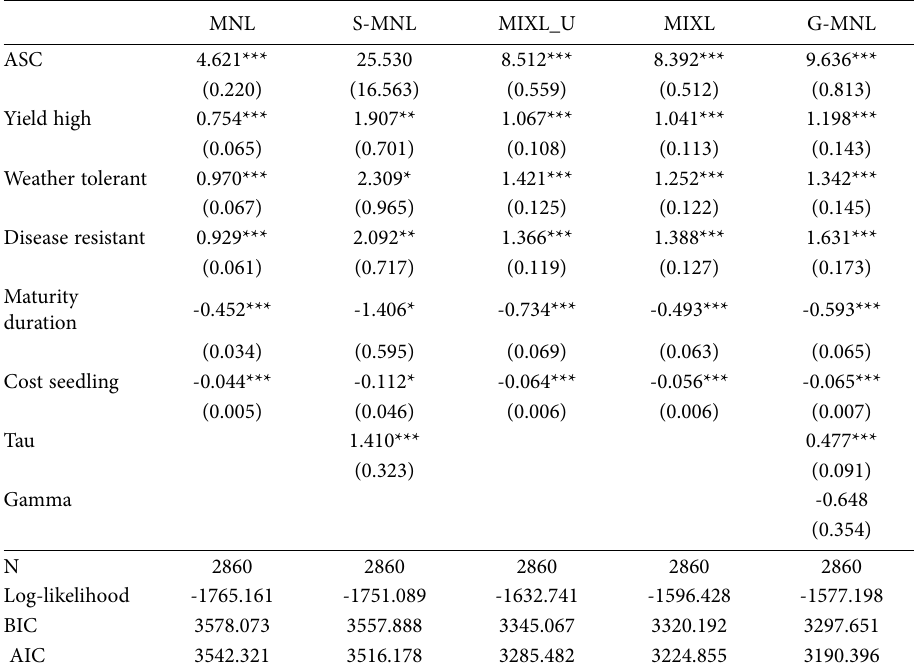
Table A-1. Results from Multinomial logit (MNL), Scaled Multinomial logit (S-MNLl, Mixed logit model with correlated alternatives (MIXL), Mixed logit model without correlation (MIXL_U) and generalized multinomial logit (G-MNL)